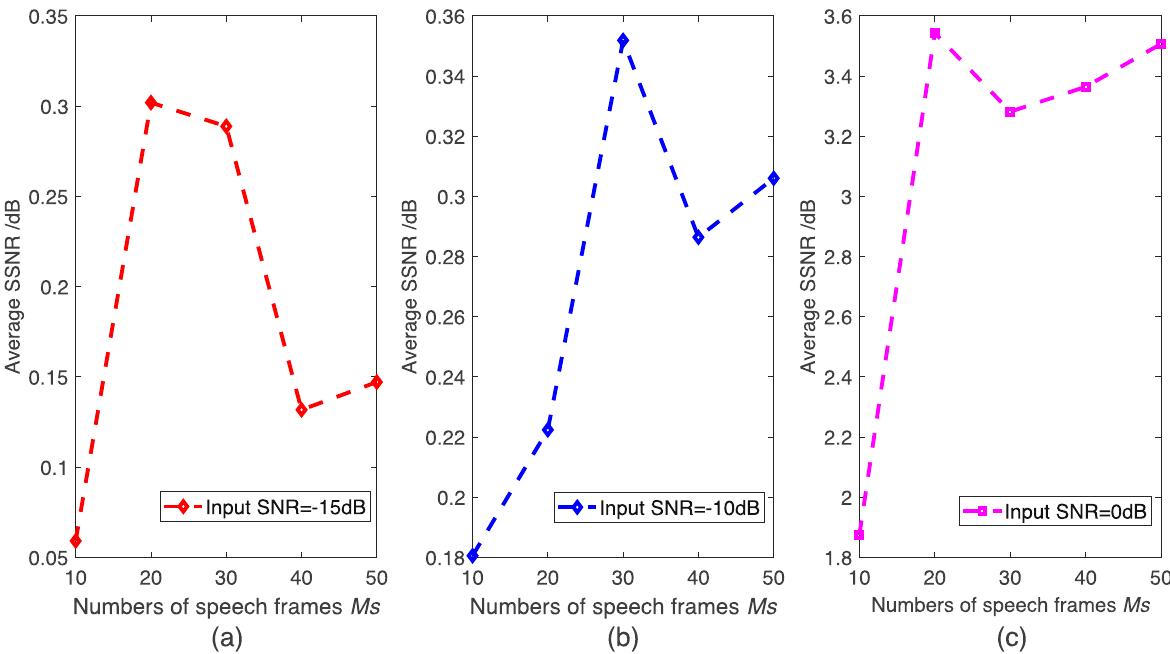
Fig. 3 The output SNR versus the cluster number K of the proposed GMMSE-KGL